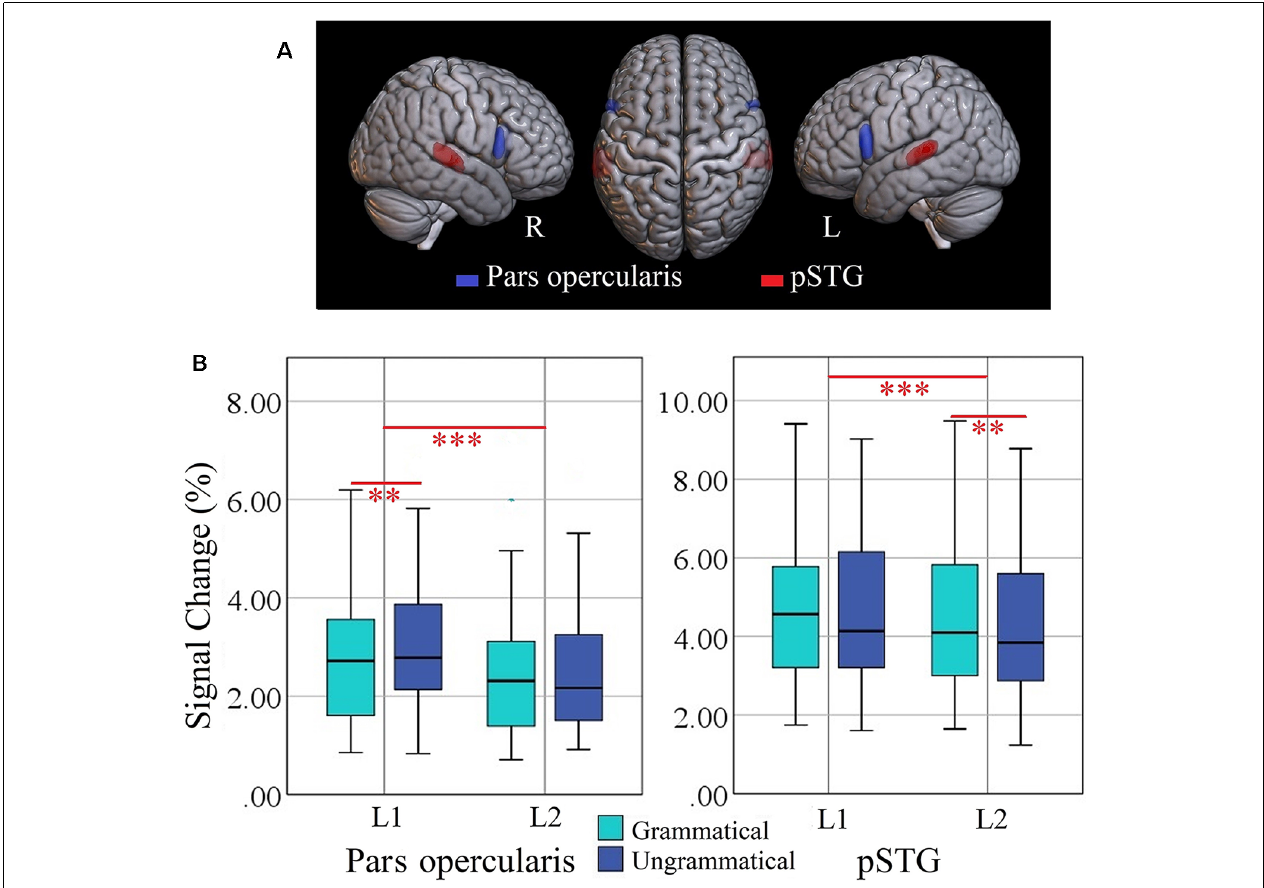
FIGURE 3 | (A) Locations of ROIs representing pars opercularis (blue) and posterior superior temporal gyrus (pSTG, red). (B) Box plots of percent signal change (%SC) values, for each language (L1 = Turkish; L2 = Persian) and condition per ROI in the left hemisphere. Significant effects are indicated by the horizontal red bar (repeated measures ANOVA, Bonferroni-corrected ∗∗∗ p < 0.025; two-tailed t-test, Bonferroni-corrected ∗∗ p < 0.006). ROI, region of interest.